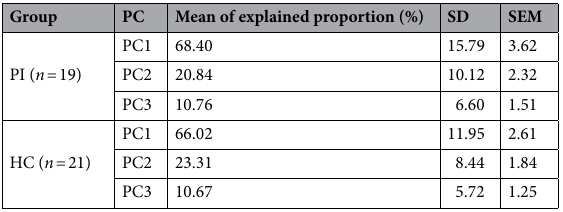
Table 2. Summary statistics of explained variance proportion of the three principal components. * PC principal component, SD standard deviation, SEM standard error of the mean.